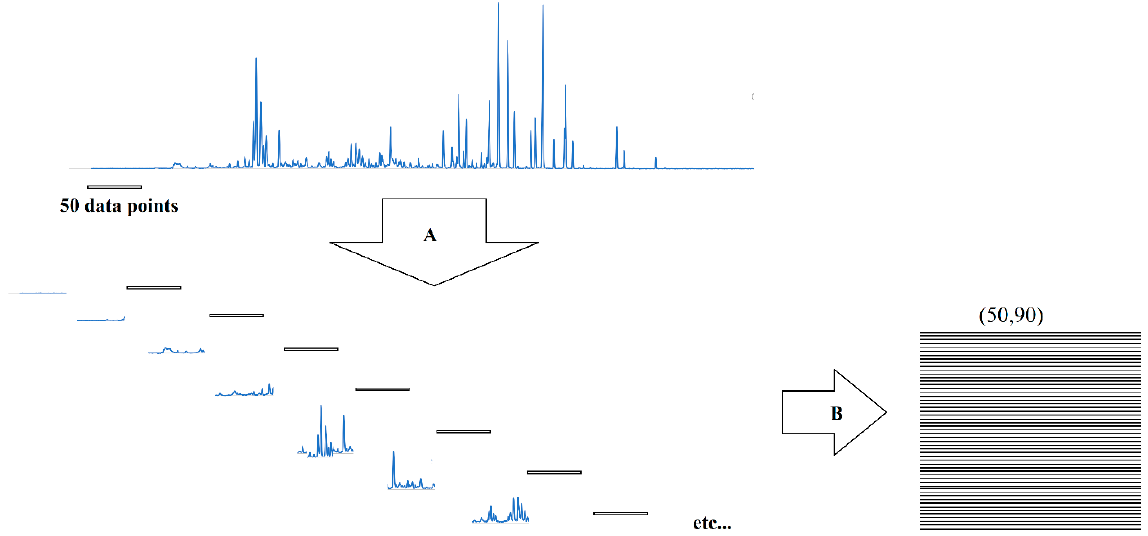
Figure 6. The basic cut-and-stack method of converting a 1-dimensional array to a 2-dimensional array. The spectral data were converted into a 2-dimensional matrix.